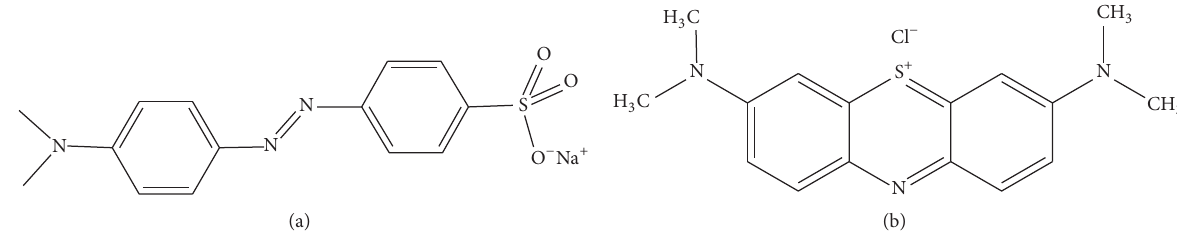
Figure 4: Structure of (a) methyl orange and (b) methylene